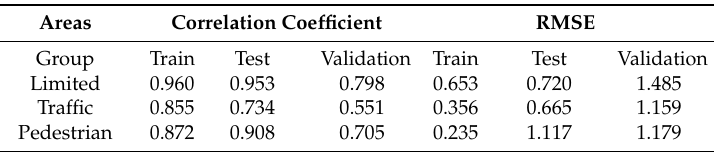
Table 4. Correlation coefficient and root mean square error for the train (RMSE), test and validation sets of the best performing model in each group of